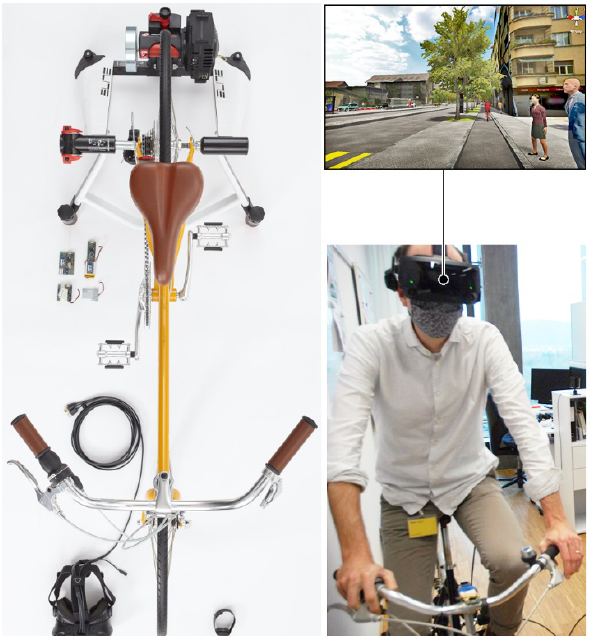
Figure 1. Biking Simulator: left: Bike with motion sensors and VR glasses (Photo source: Tobias Wootton); right: the simulator in action and the view during the test for the presented use